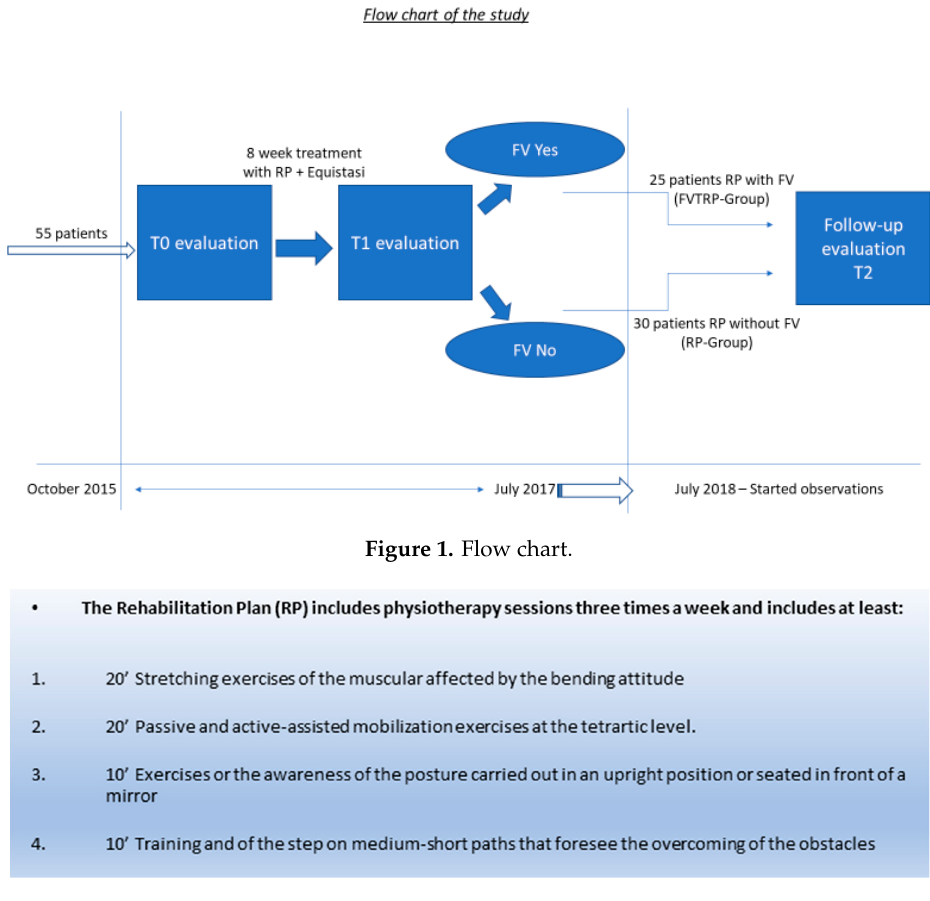
Figure 2. Rehabilitative plan (RP).